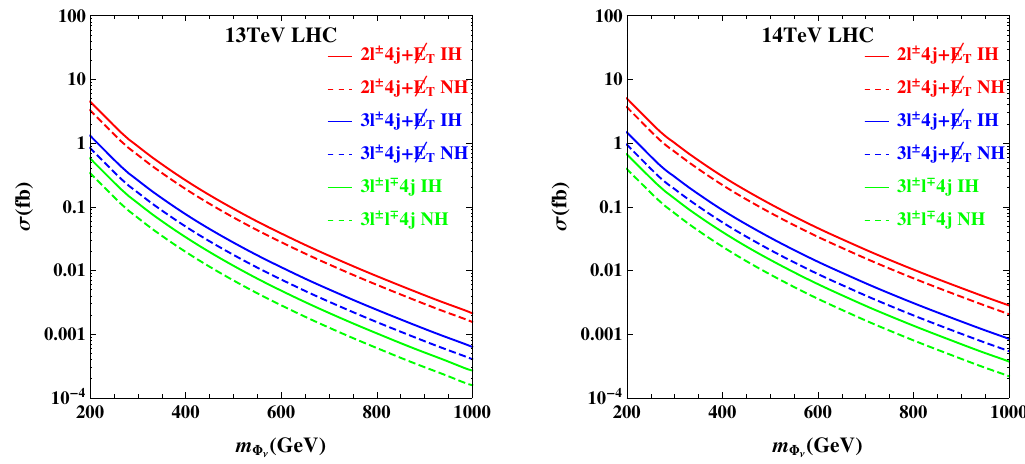
Figure 9 . Cross sections of LNV signatures at 13 (14) TeV